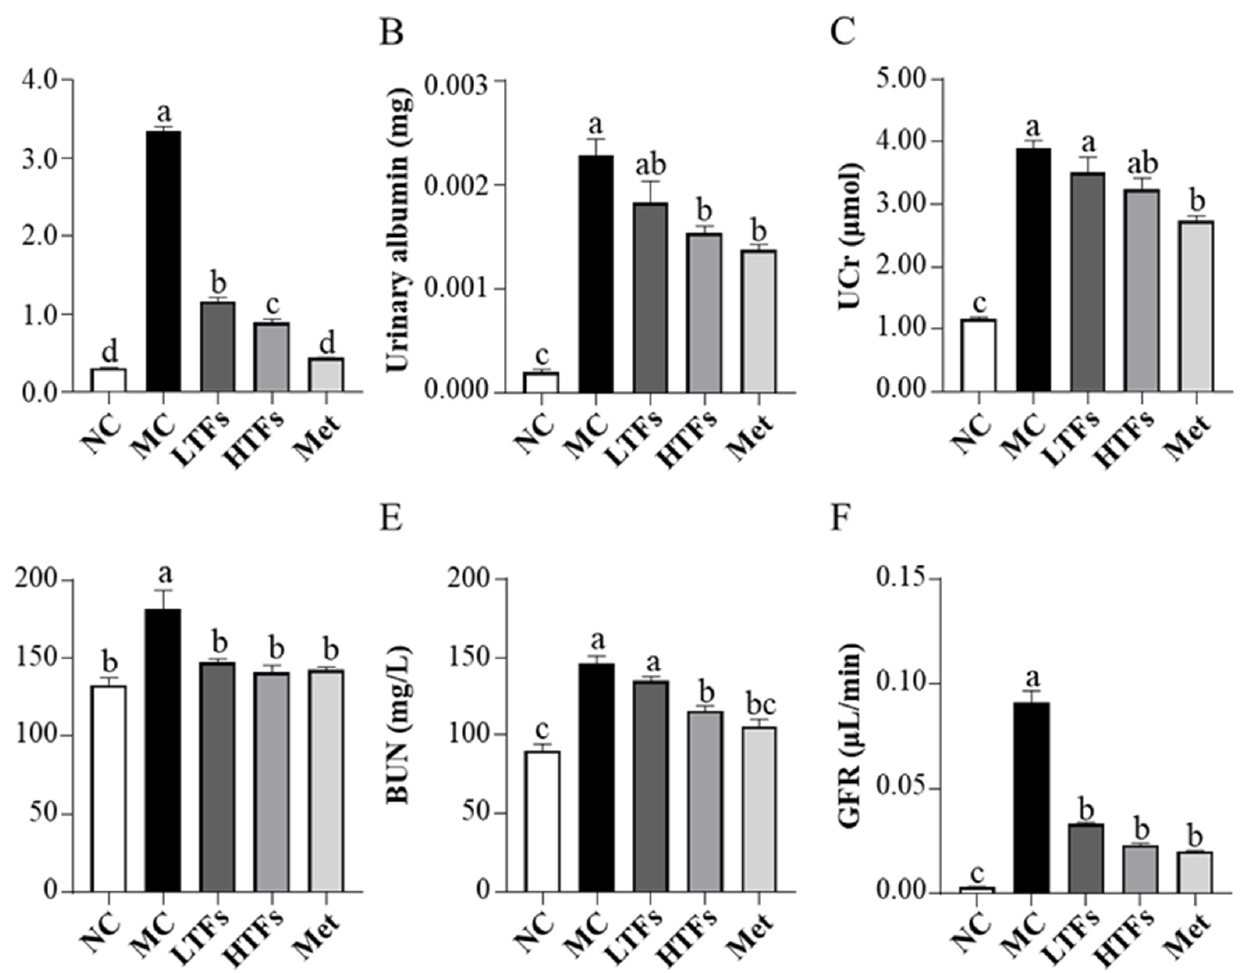
Figure 4. The HE-stain images of kidney tissues of the mice in each group. ( A) and (B) : kidney tis- sues images of normal control group mice. ( C) and (D) : kidney tissues images of diabetic model control group mice. ( E) and (F) : kidney tissues images of low-dose TFs group mice. ( G) and (H) : kidney tissues images of high-dose TFs group mice. ( I) and (J) : kidney tissues images of metformin group mice. Square: glomerular mesangial expansion; rhombus: hyalinization of renal glomerular; triangle: renal tubular epithelial cell exfoliation; arrow: renal tubular epithelial cell vacuolar degen- eration; star: glomerular atrophy. Scale bars are 50 μ m and 100 μ m respectively. NC: normal control; MC: diabetic model control; LTFs: low-dose TFs; HTFs: high-dose TFs; Met: metformin. 3.4. TFs Intervention Reduced the Level of AGEs in T2DM Mice